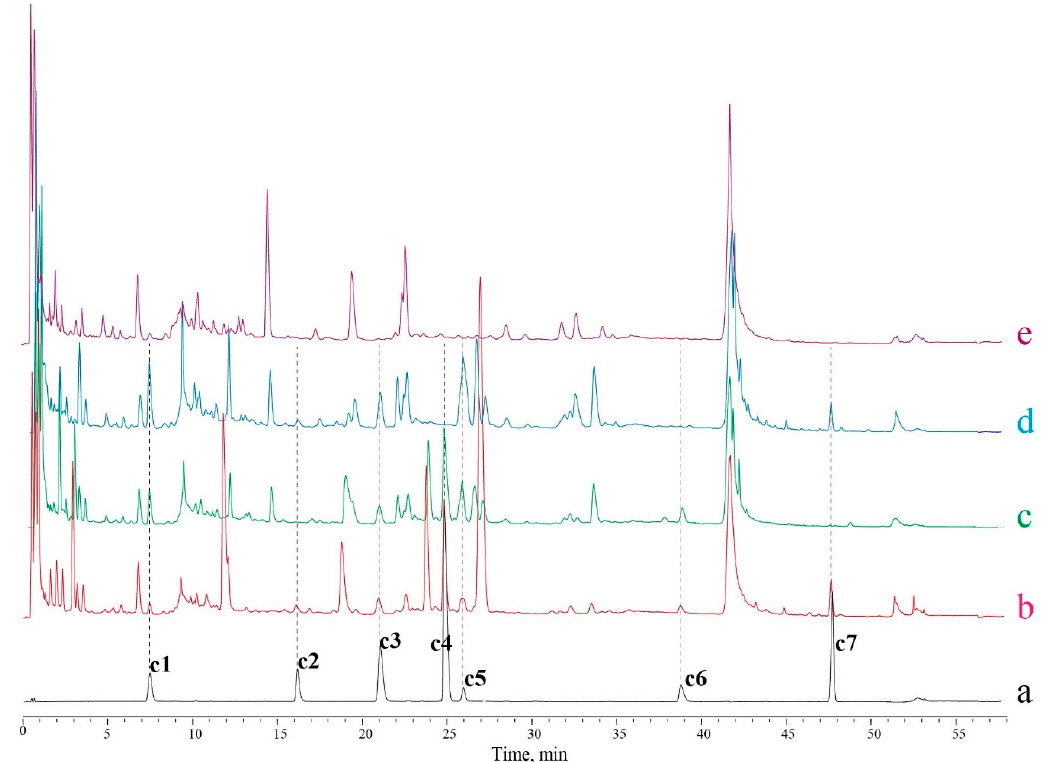
Figure 2. The UPLC chromatogram of standard solutions, samples and negative control samples. ( a ): Mixed standards solution; ( b ): Sample S1; ( c ): Negative control sample of Glycyrrhizae Radix deficiency; ( d ): Negative control sample of Forsythiae Fructus deficiency; ( e ): Negative control sample of